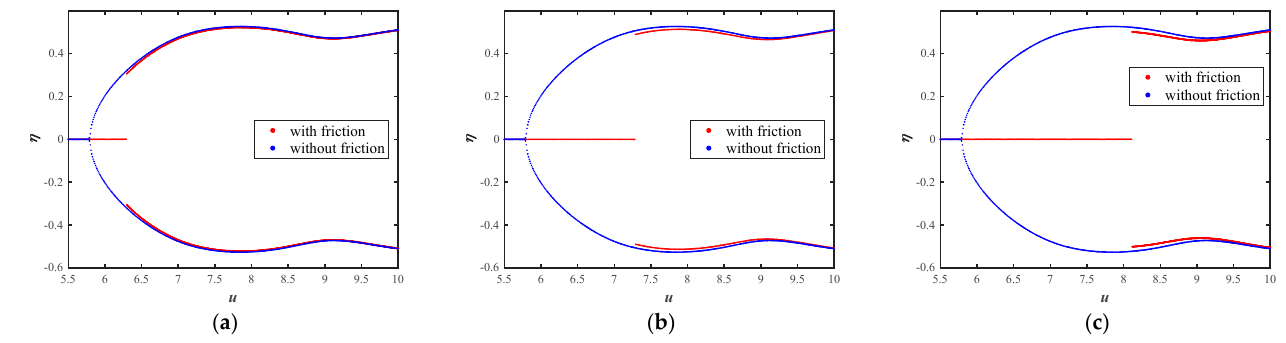
Figure 4. Bifurcation diagrams for the tip − end responses of the pipe with different dry friction forces when α = 0.001, β = 0.213, and ξ d = 0.5: ( a ) f n = 0.1; ( b ) f n = 0.3; ( c ) f n =